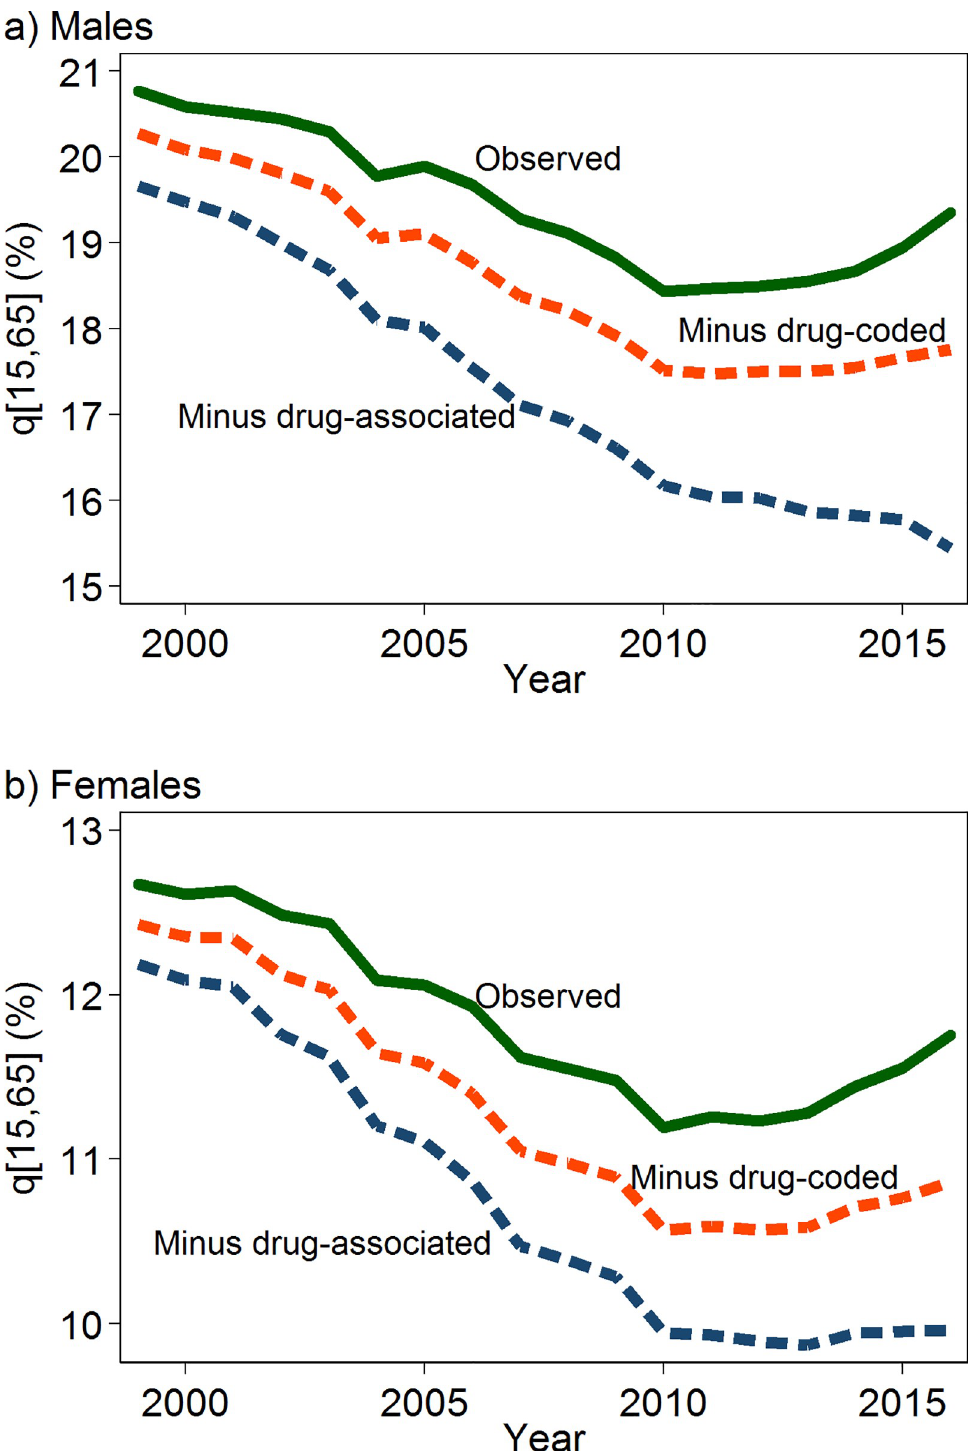
Fig 4. Percentage dying between age 15 and 65 ( q [15,65]) with and without drug use, US, 1999–2016, by sex. Note: Estimates are based on the model that includes smoking.